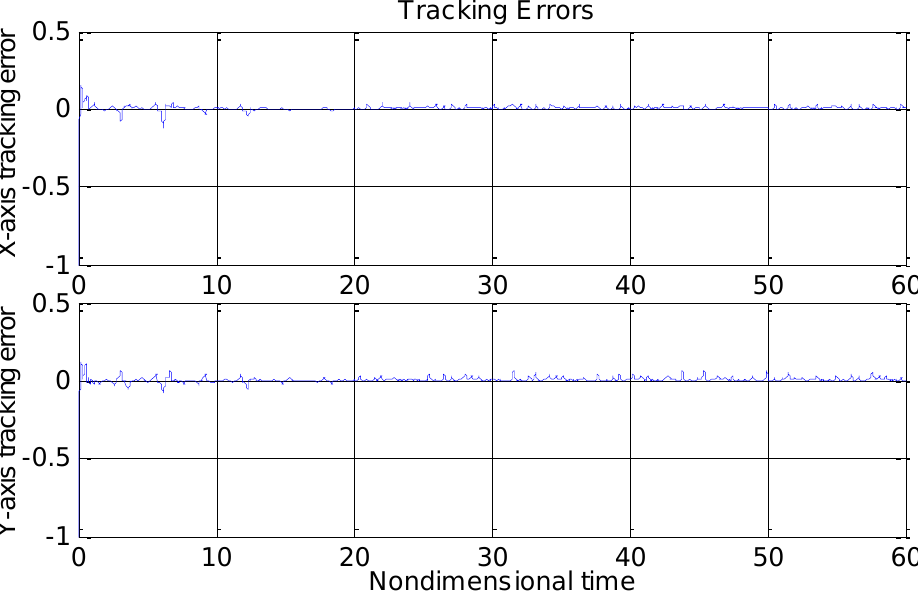
Figure 8. Tracking errors using ABC under step disturbances with robust term.